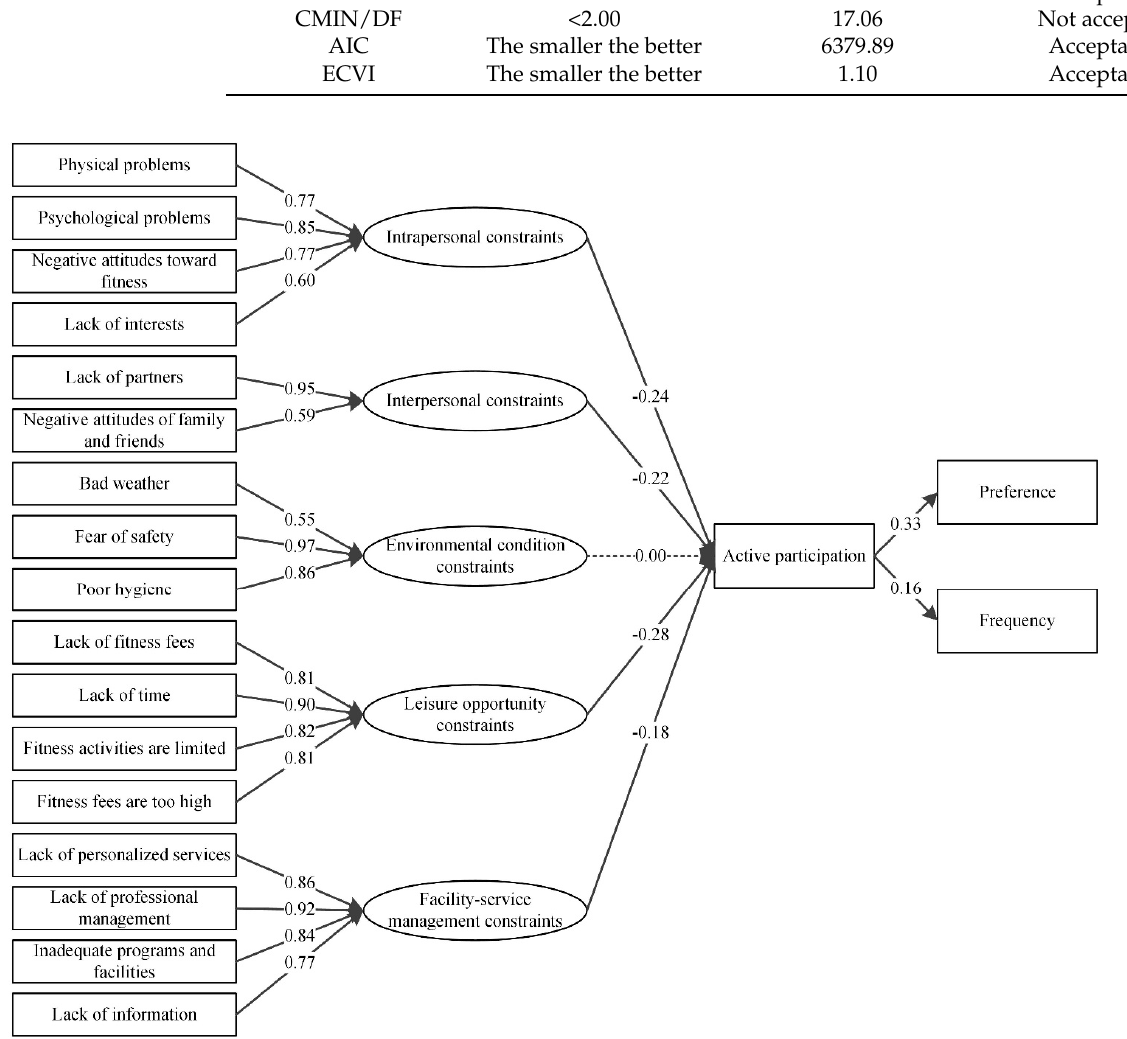
Figure 4. The path of the standardized estimates for female groups in structural residuals model.